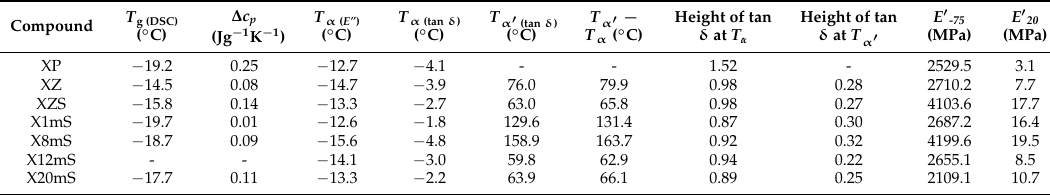
Table 4. The results of thermal analysis of XNBR vulcanizates.